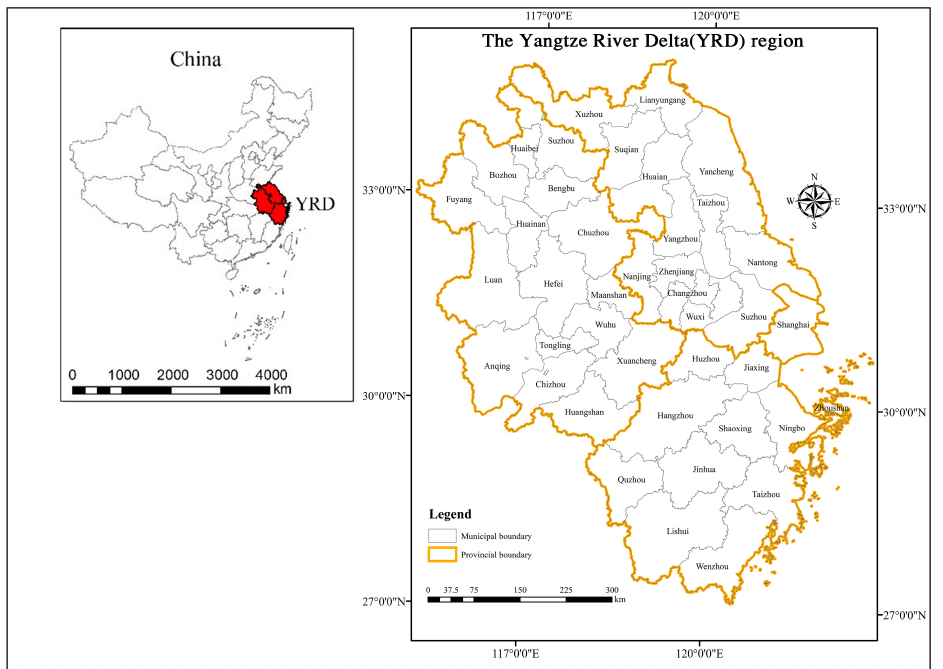
Figure 1. Study area.